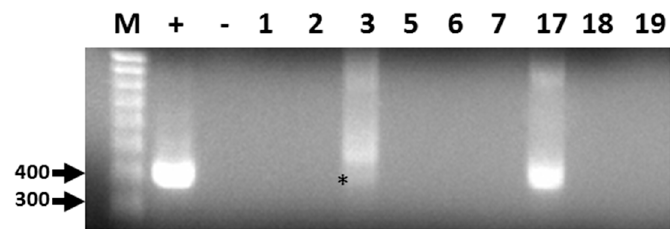
Figure 1. Representative results of RT-PCR detection of alphacoronavirus vRNA in Brazilian free-tailed bat feces (BF). Lane 1 (M), 100 bp MW markers; Lane 2 (+), HCoV-NL63 vRNA, positive control; Lane 3 ( − ), negative control; Lane 4, BF#1; Lane 5, BF#2; Lane 6, BF#3; Lane 7, BF#5; Lane 8, BF#6; Lane 9, BF#7; Lane 10, BF#17; Lane 11, BF# 18; Lane 12, BF#19. Virus-specific 440-bp PCR products amplified by PCR primers CorTheoNL63F1 and CorTheoNL63R1 are present in lanes 2, 6 (asterisk), and 10.